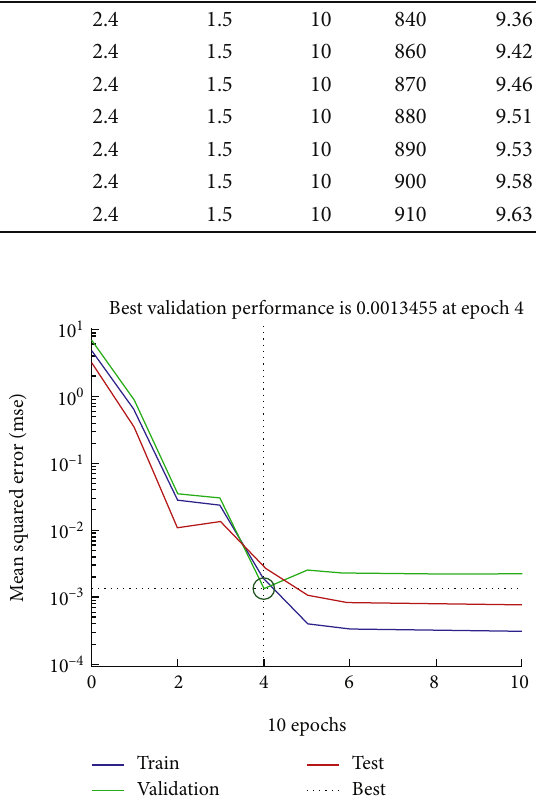
Figure 9: Mean square error of training